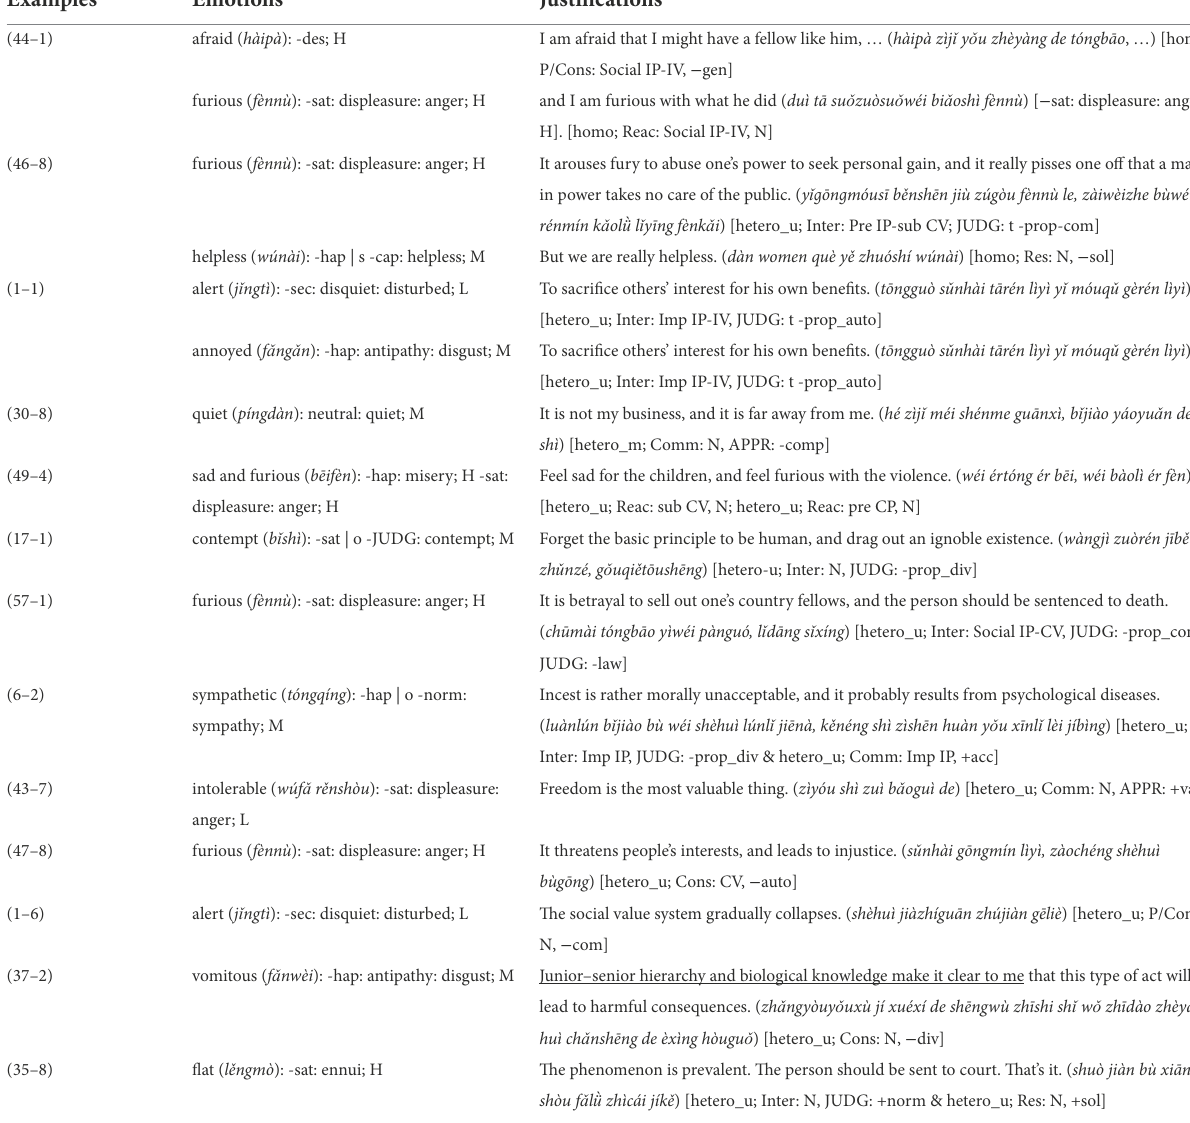
TABLE 5 Sample responses and justifications and their annotations.